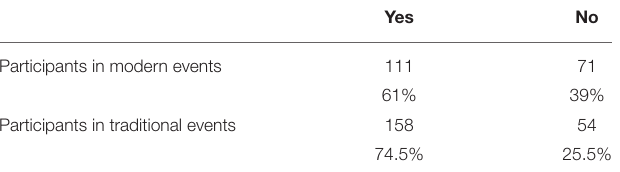
TABLE 2 | Previous participation in traditional rafting.